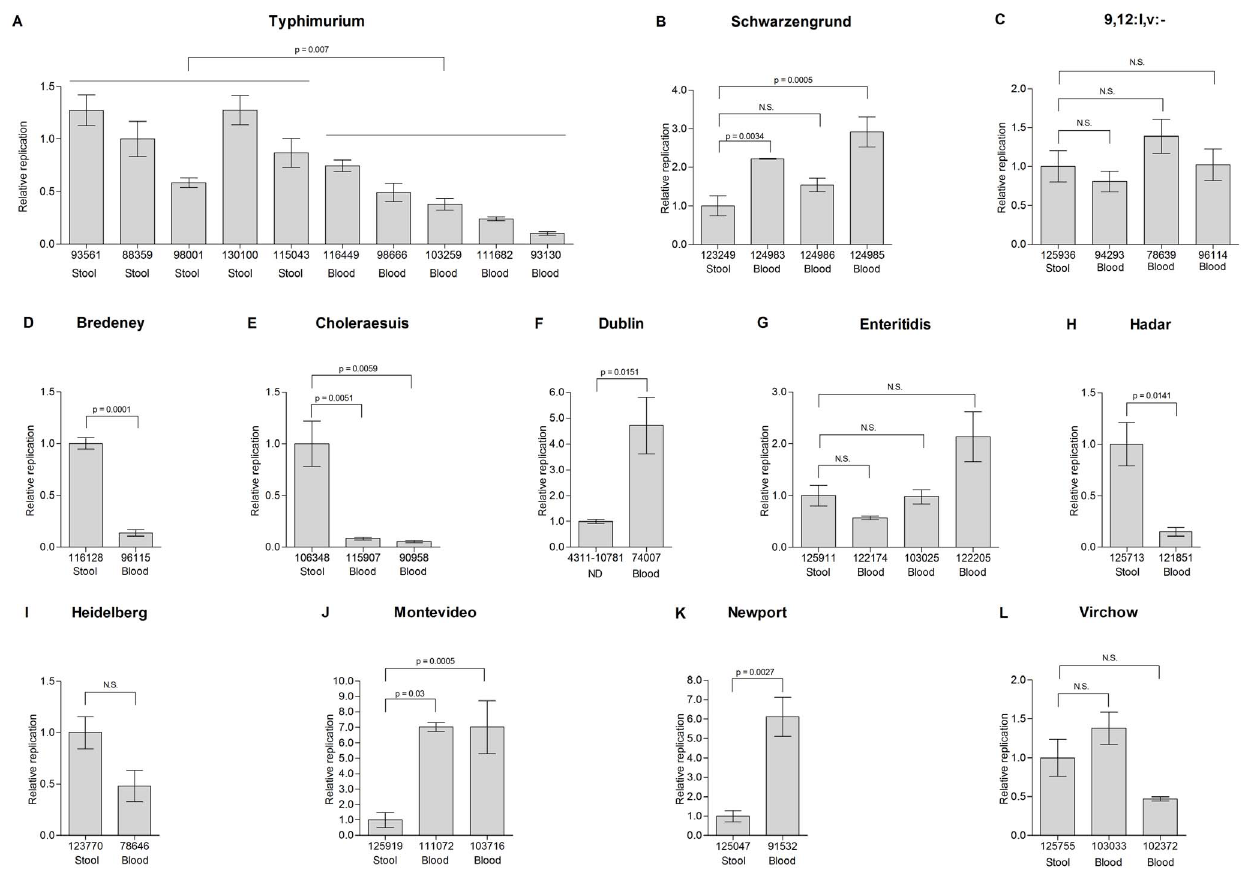
Figure 7. Intracellular growth of invasive and enteritis strains in epithelial cells. Clinical isolates (N=41) from blood and stool sources were grown to late logarithmic phase in LB medium and used to infect epithelial HeLa cells at a MOI of , 100:1. Intracellular replication (ratio between recovered CFU at 24 h/CFU at 2 h p.i.) is shown in relation to the stool isolate of each serovar. In S . Typhimurium, replication is presented relative to median value of the stool isolates (isolate 88359). Indicated values present the mean and the SEM of at least 4 independent infections.